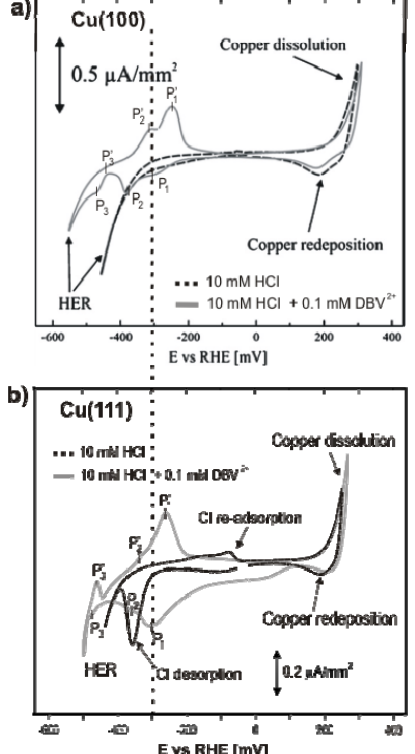
Figure 2. Representative steady-state cyclic voltammograms (CVs) of ( a ) Cu(100) and ( b ) Cu(111) in pure 10 mM HCl solution (dashed black curves) and in (10 mM HCl + 0.1 mM DBV) electrolyte (grey curves), respectively; d E /d t = 10 mV/s. Figure 2a is reproduced with permission from